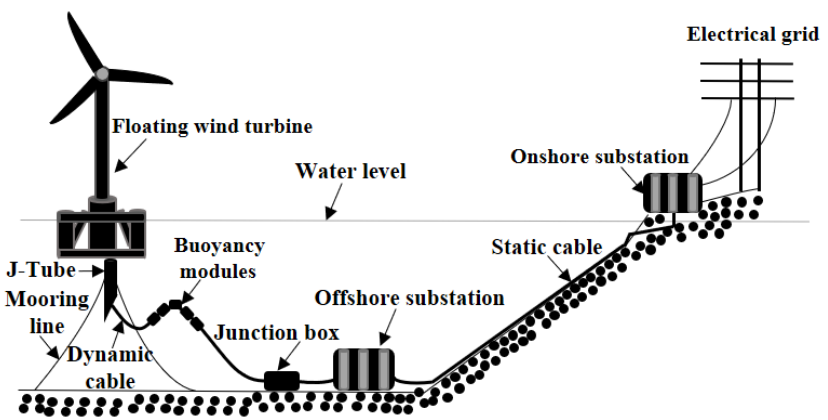
Figure 1. Power transmission system of floating offshore wind turbine.